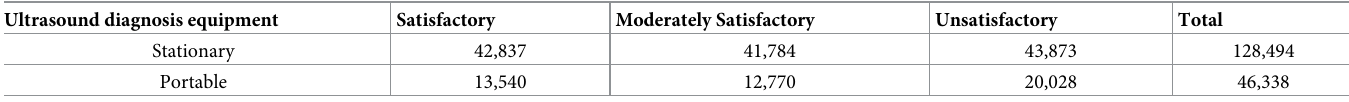
Table 2. Description of the dataset.